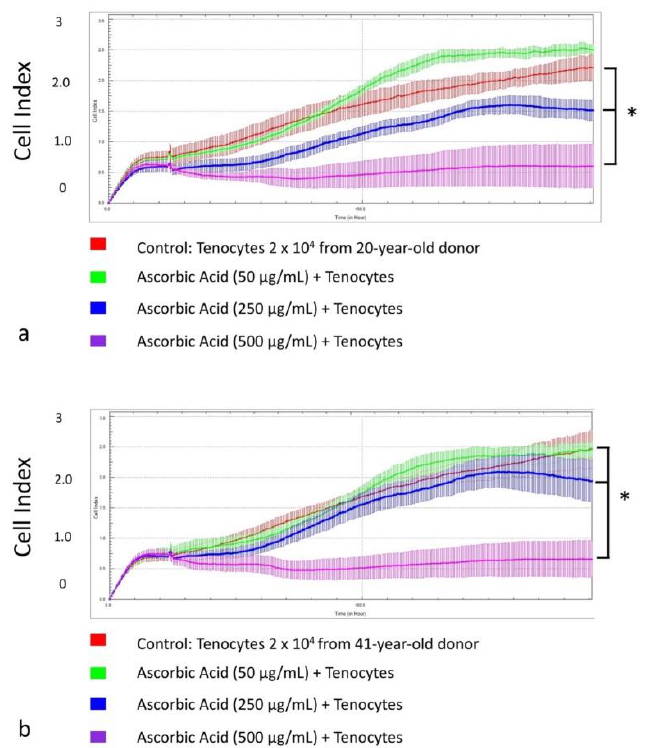
Figure 3. Real-time changes of cell index (CI) when tenocytes were exposed to di ff erent concentrations of ascorbic acid. ( a ) Cell index when tenocytes were exposed to 50, 250, and 500 µ g / mL ascorbic acid in the 20-year-old patient. ( b ) Cell index when tenocytes were exposed to 50, 250, and 500 µ g / mL ascorbic acid in the 41-year-old patient. * p < 0.05.